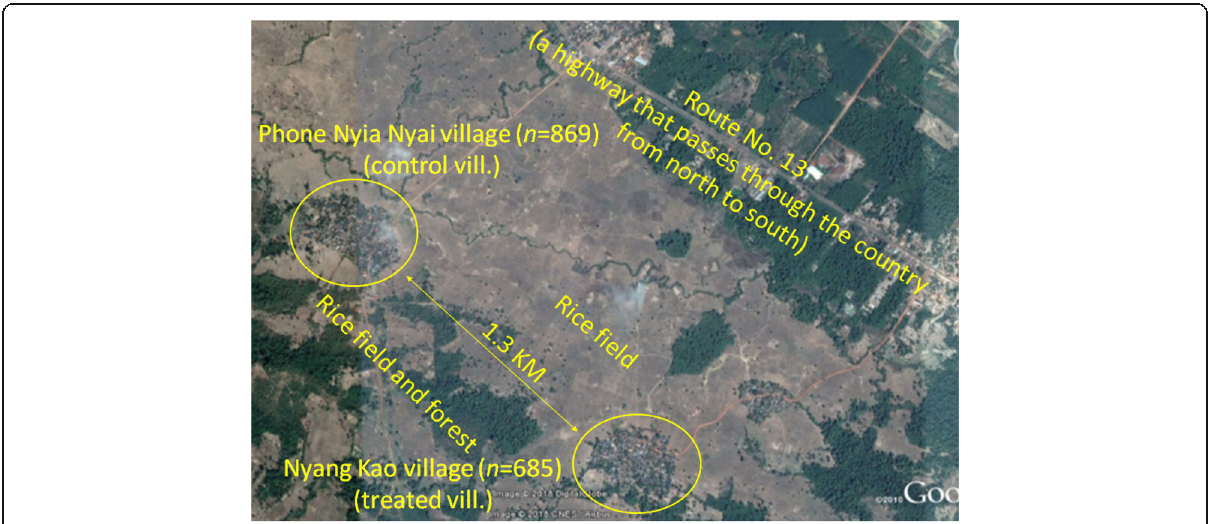
Fig. 1 Two villages in Thakhek district, Khammouane Province. Aerial distances were measured using Google